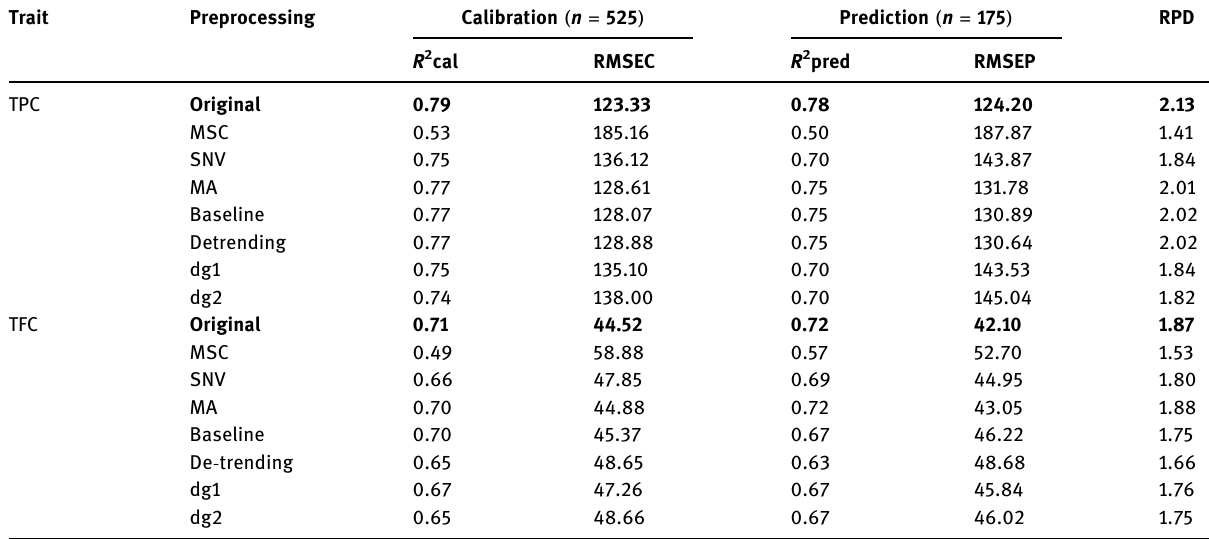
Table 2: PLS regression results for prediction of total phenolic ( TPC ) and fl avonoid content ( TFC ) in horticultural products